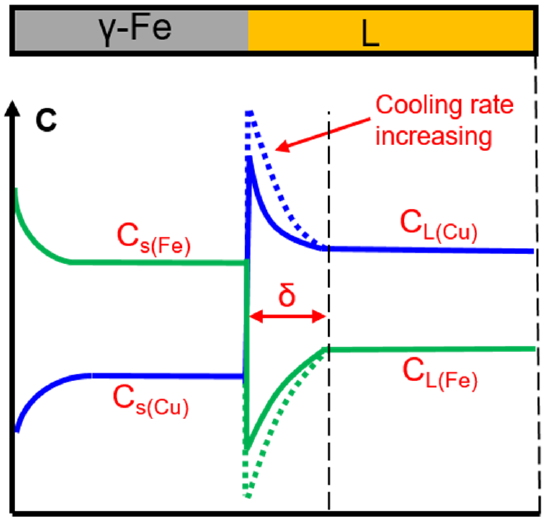
Figure 13. Schematic of the near-equilibrium solidification. Rutter and Tiller et al. [30] believed that constitution undercooling in the liquid phase produced at the front of the solid–liquid interface can cause instability of the solidification flat interface and form cellular, dendritic crystal structures.